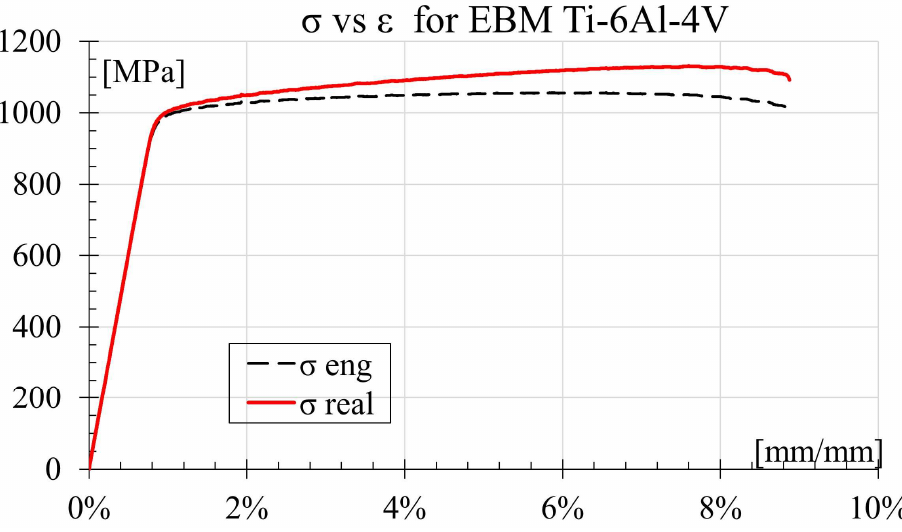
Figure 5. Engineering and real stress–strain curves for the EBM Ti–6Al–4V alloy.